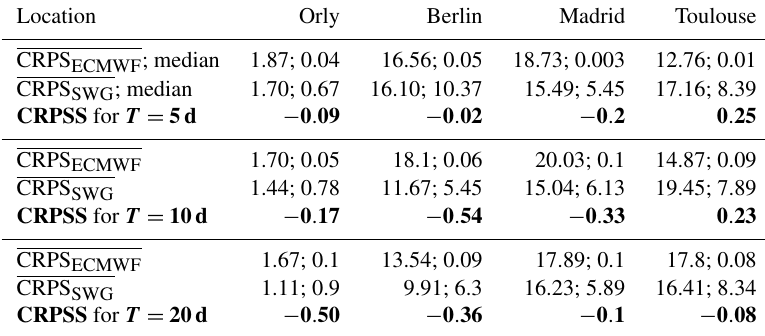
Table C1. Average and median values of CRPS, average CRPSS (in bold) of the ECMWF and SWG forecasts for lead times of T = 5, 10, and 20d. The table shows that the CRPS of the SWG forecast has a smaller average than the CRPS of the ECMWF forecast, which explains the values of CRPSS for the different studied areas and the positive improvement of the SWG compared with the ECMWF. Location Orly Berlin